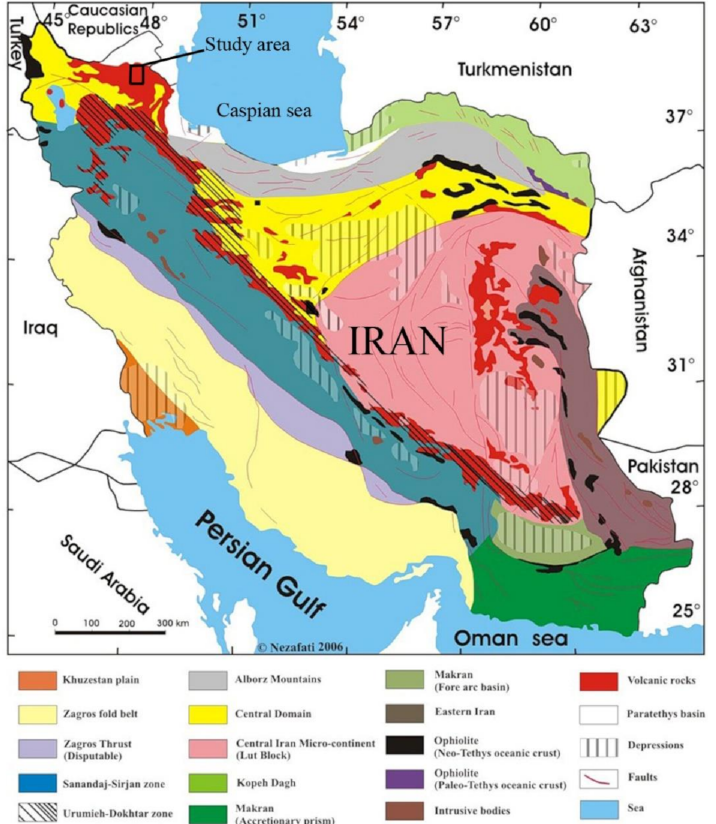
Figure 1. Tectonic scheme of Iran with the main tectonic subdivisions, modified after [15,45,46] and publications of the Geological Survey of Iran